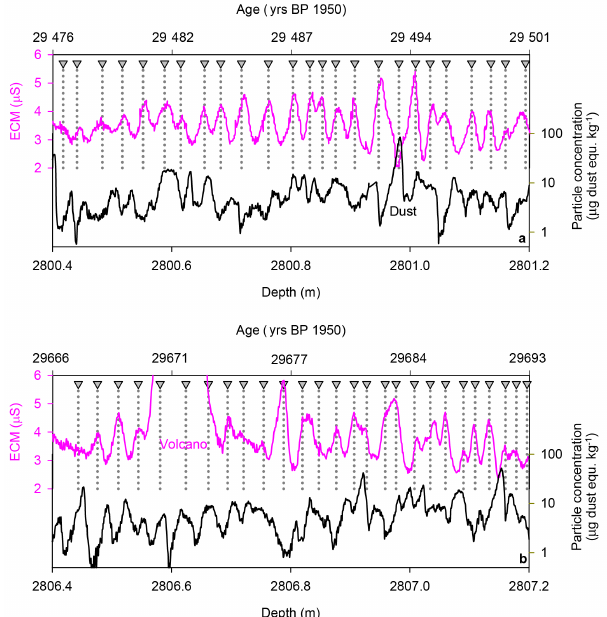
Figure 7. Example of two 0.8m long ice core sections of WD from (a) approximately 29500 and (b) 29700 yearsBP, with annual- layer markers indicated. Annual layers are here identified by match- ing pairs of winter and summer tracers. Summers are characterized by ECM maxima. Winters are indicated by maxima in dust depo- sition derived from the WD insoluble particle concentration record using the particle size range <1.2µm typical for dust transported over large distances. Dust concentrations are shown on a logarith- mic scale. Also shown is an example (2801m) of how dust input can mask annual cycles in the ECM record by neutralizing acids present in the snowpack that are usually responsible for the annual cycle observed in electrical properties in the ice (a) . The insoluble dust record provides confident and independent information on annual layering at WAIS Divide, also in the presence of acidity excursions caused by large volcanic eruptions as indicated by a 4-year-long period of increased acidity content centred at 2806.6m depth (b)